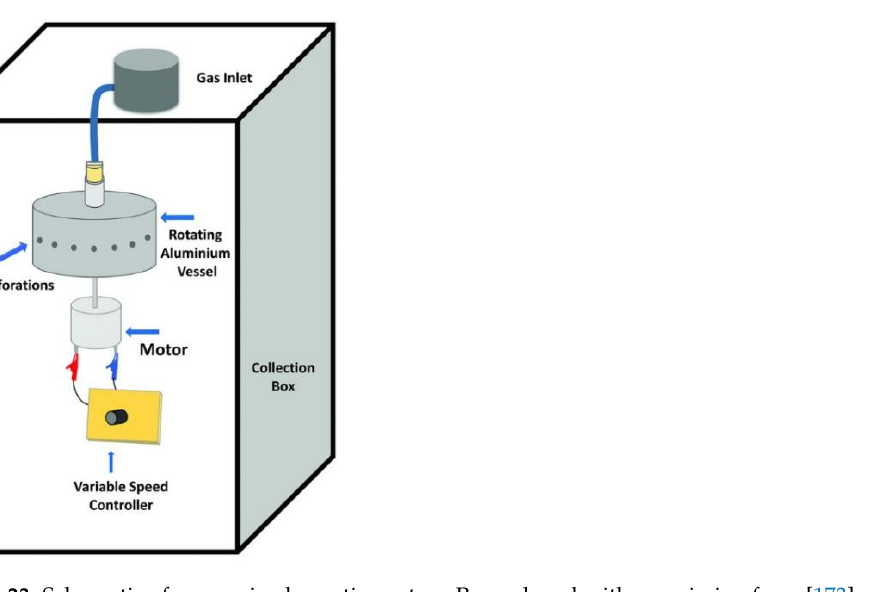
Figure 23. Schematic of pressurized gyration setup. Reproduced with permission from [173], copy- right 2018 Wiley-VCH.